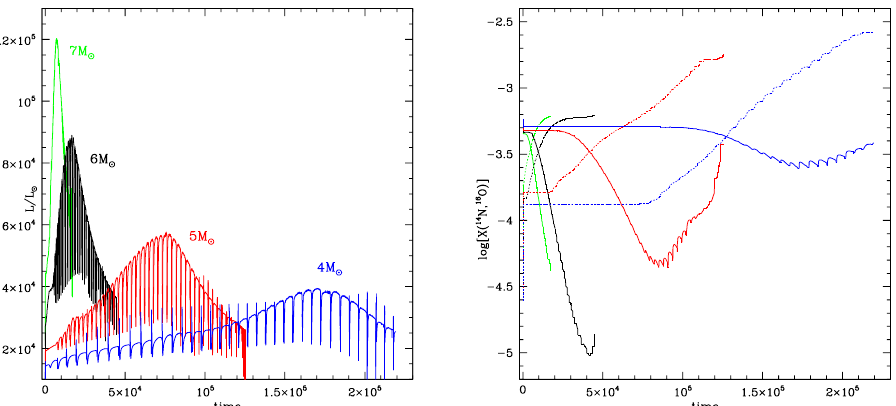
Figure 3. Time variation of the luminosity ( left panel ) and of the surface chemistry ( right ) of model stars of metallicity Z = 10 − 3 and initial mass in the 4–7 M (cid:12) range. The surface mass fractions of 16 O (solid tracks) and 14 N (dotted) are indicated in the right